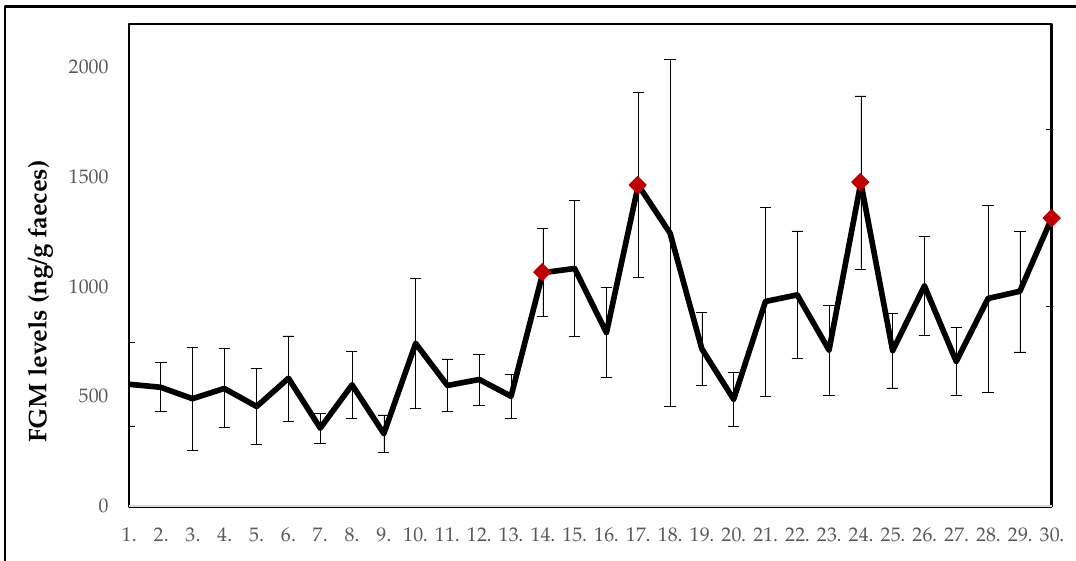
Figure 2. Mean concentrations of the faecal glucocorticoid metabolites (FGMs) in ring-tailed lemurs; significant increases compared to the first day of sampling are indicated. Red points indicate a significant increase in FGM levels.